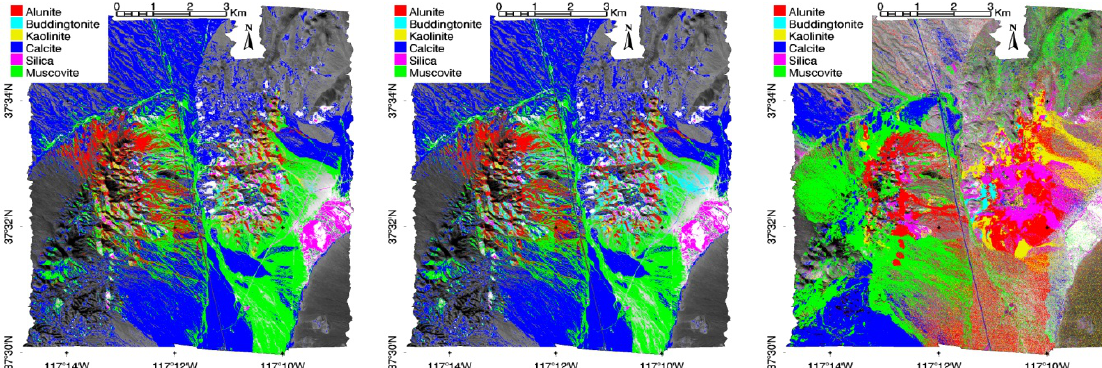
Figure 4. ( Left ) Minimum Distance classification at 7.5 m resolution using 86 AVIRIS SWIR bands; ( Center ) Minimum Distance classification at 7.5 m using 8 simulated WV-2 SWIR bands; ( Right ) MTMF mineral map at 7.5 m resolution using 86 AVIRIS SWIR bands. Visual comparison and the confusion matrix (Table 2) indicates that the AVIRIS and simulated WV-3 supervised classification produces similar, highly correlated results, however, neither really matches the known mineral distribution at Cuprite very well (Right and